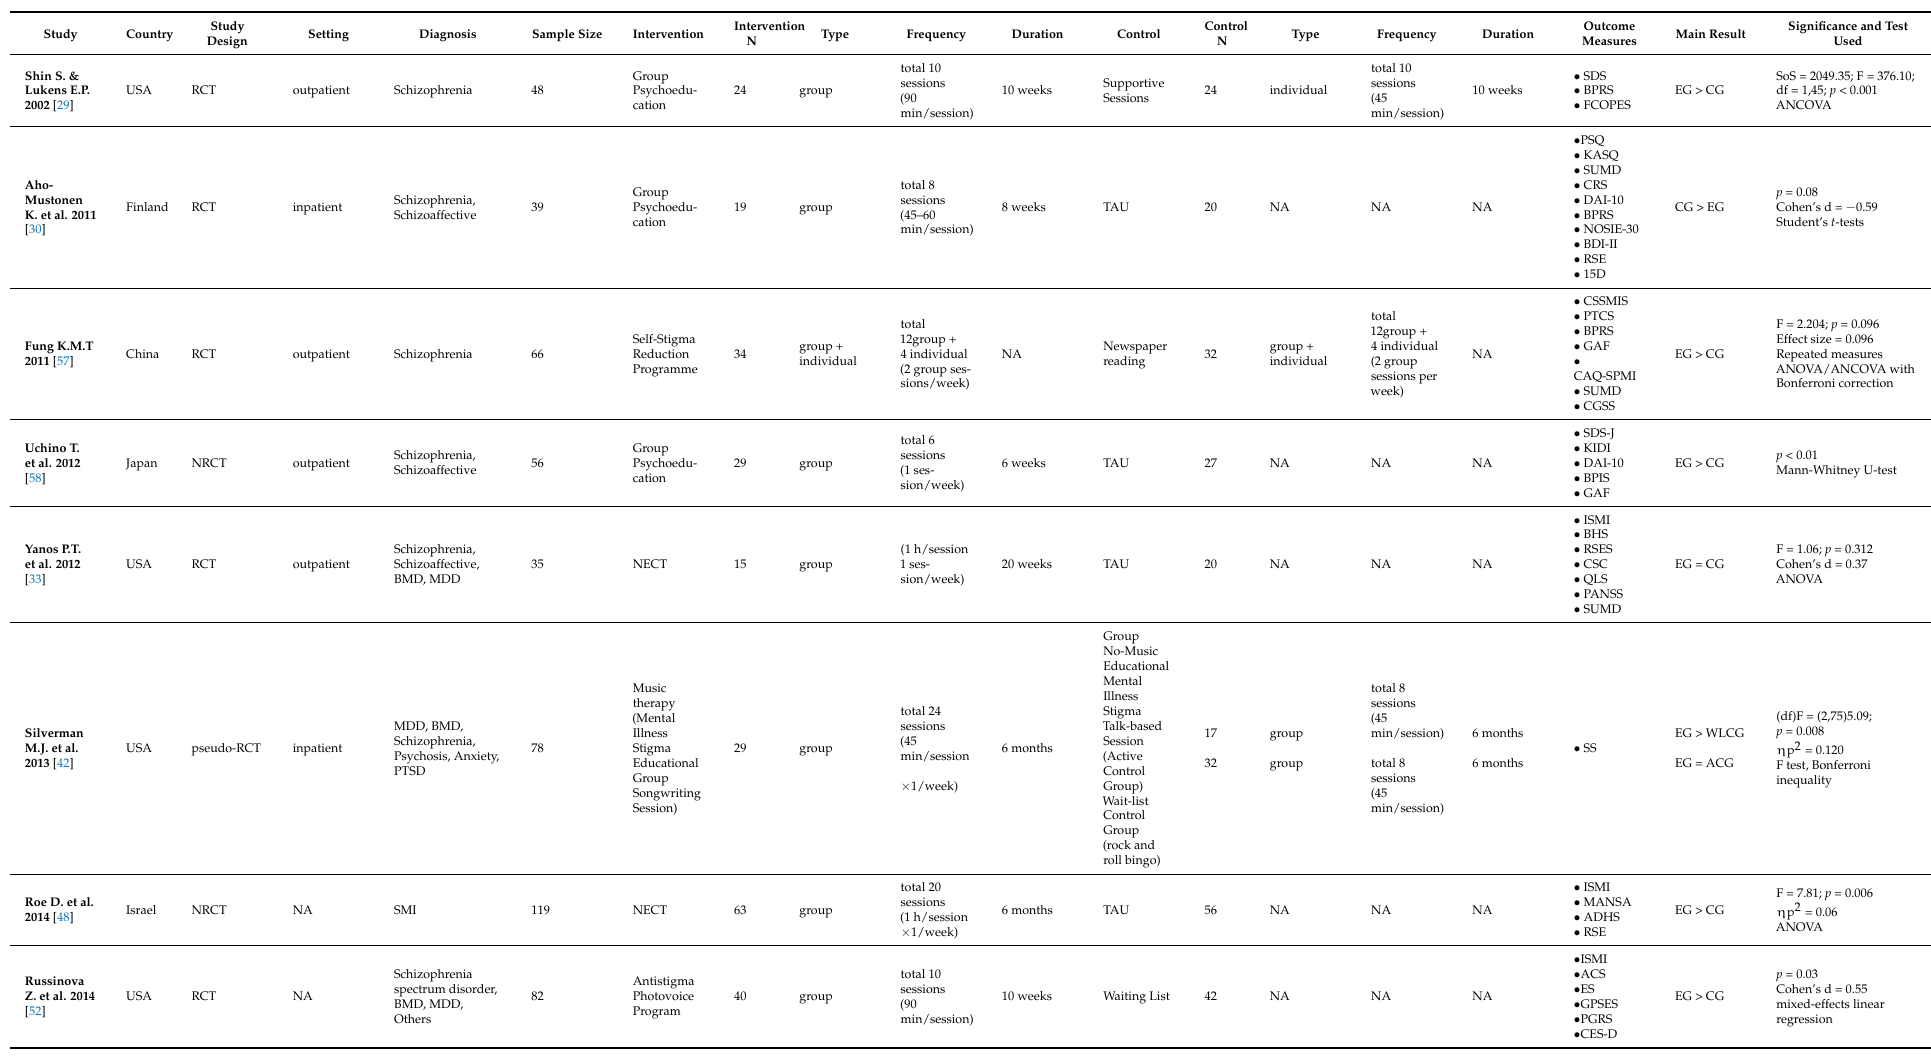
Table 1. Study characteristics